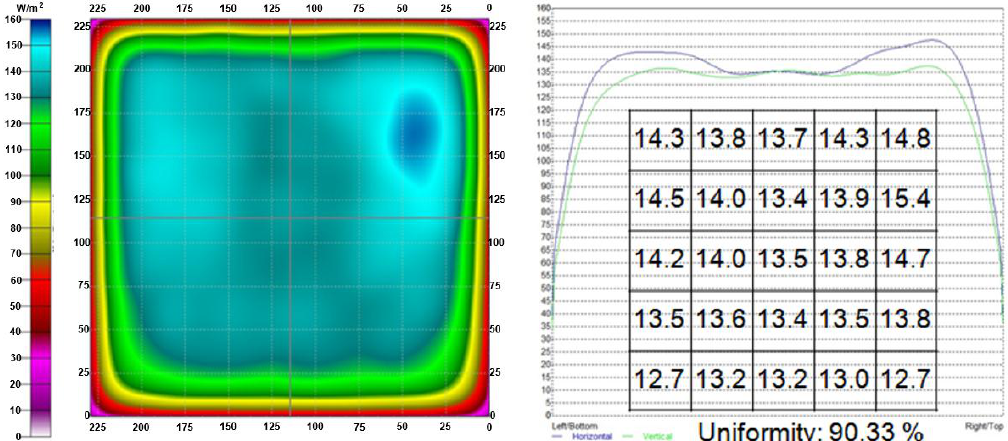
Figure 27. Simulation results of LED power adjustment type 2.